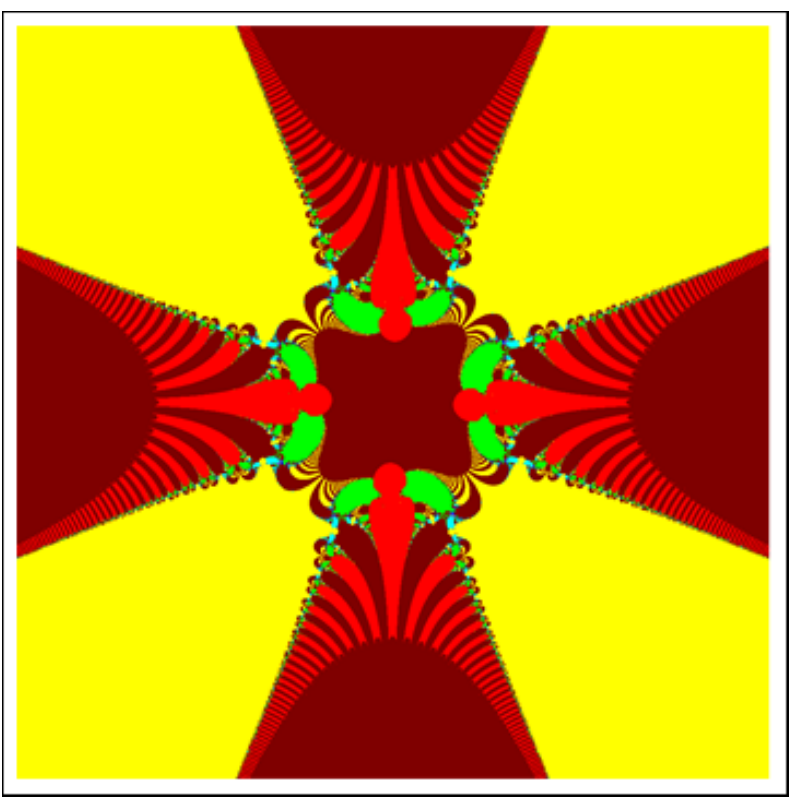
Figure 18. J-set for τ ( z ) = e z 4 + c via DKIS. The image execution time is 344.49 s.